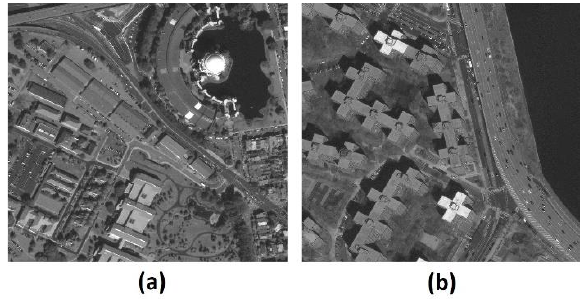
Figure 7. Base layers: (a) San Francisco dataset, (b) NY dataset